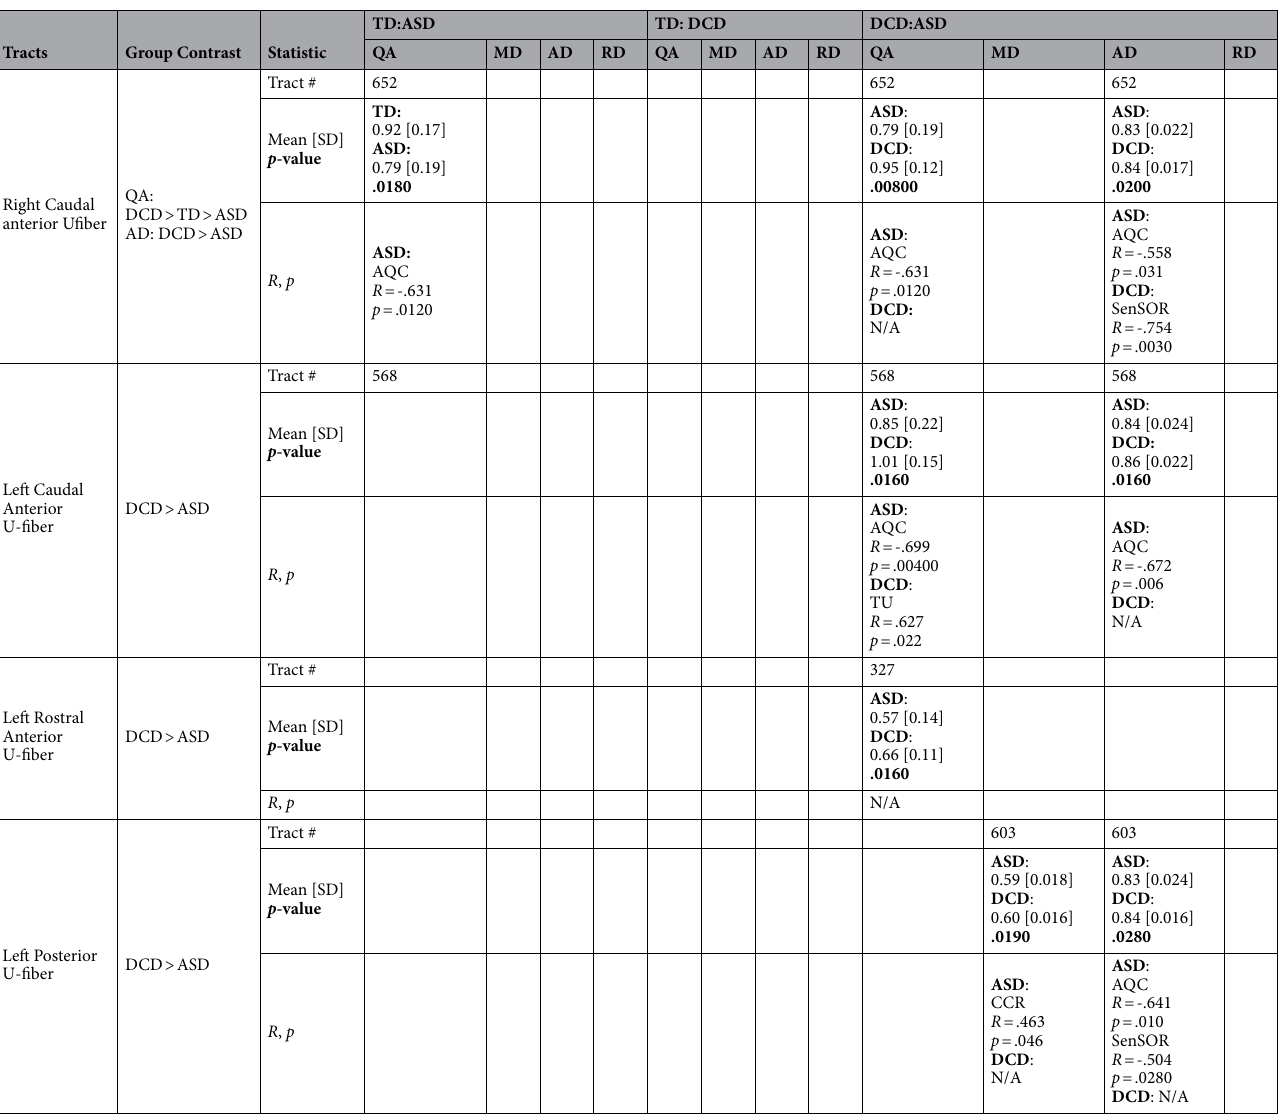
Table 4. U-fiber ROIs: Between group diffusion differences and significant ASD and DCD group correlations. ASD = autism spectrum disorder; DCD = developmental coordination disorder; TD = typically